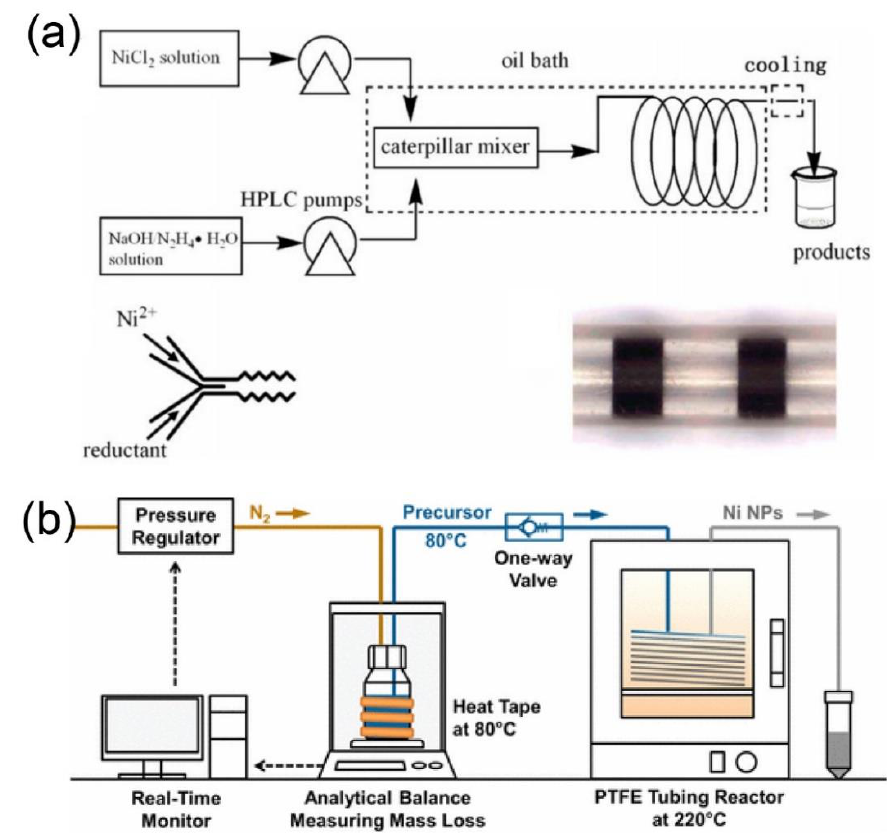
Figure 4. ( a ) Schematic illustration of the micro-reaction process for synthesis of crystalline nickel nanoparticles using an oil bath-heated capillary-type mixer (reproduced from [45], with permission from the Elsevier, 2012). ( b ) Reactor system for the continuous flow production of nickel nanoparticles (reproduced from [46], with permission from the American Chemical Society, 2017).